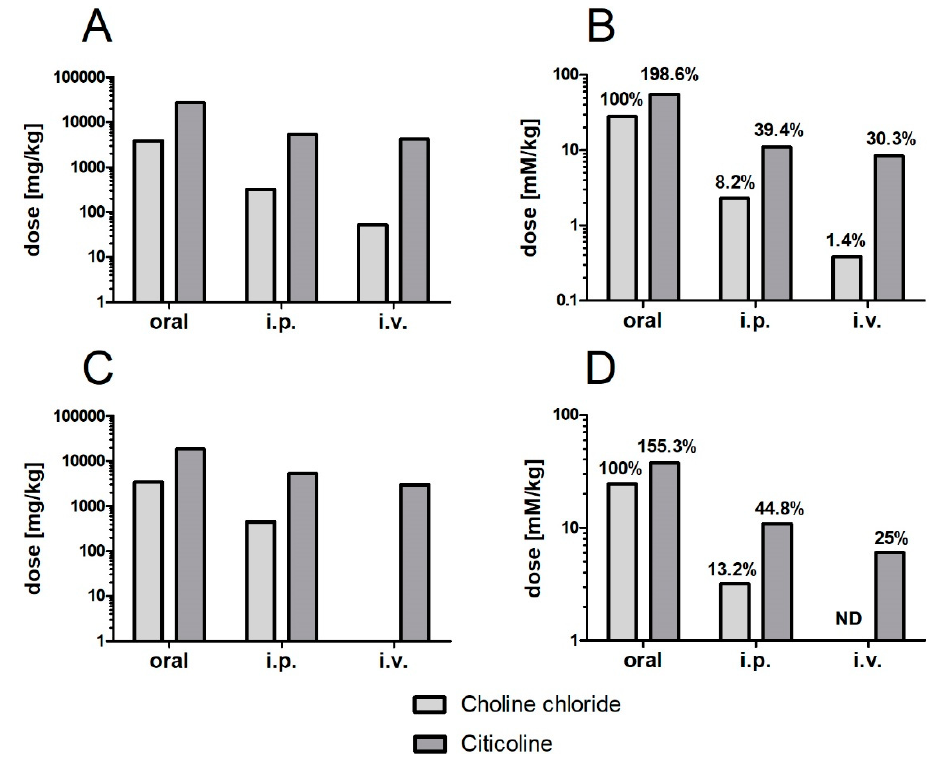
Figure 1. Median lethal dose of choline chloride and citicoline in mice ( A , B ) and rats ( C , D ) expressed in milligrams ( A , C ) or in millimoles ( B , D ) per kilogram body weight, depending on the route administration. Data compiled from refs. [27–31]. Abbreviations used: i.v., intravenous; i.p.,